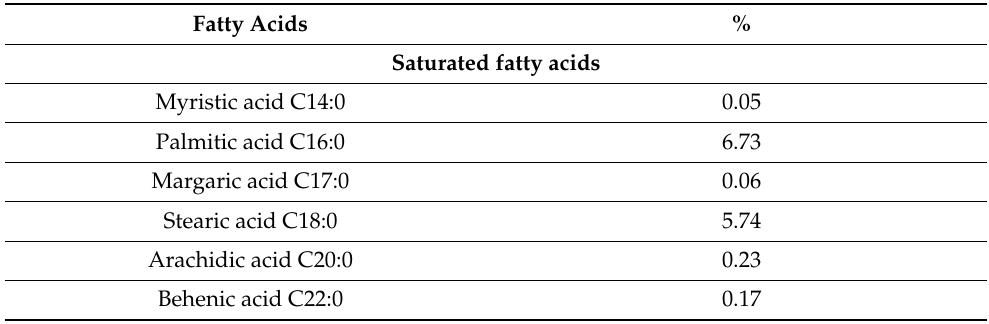
Table 1. Fatty acids percentage of Opuntia ficus-indica seed